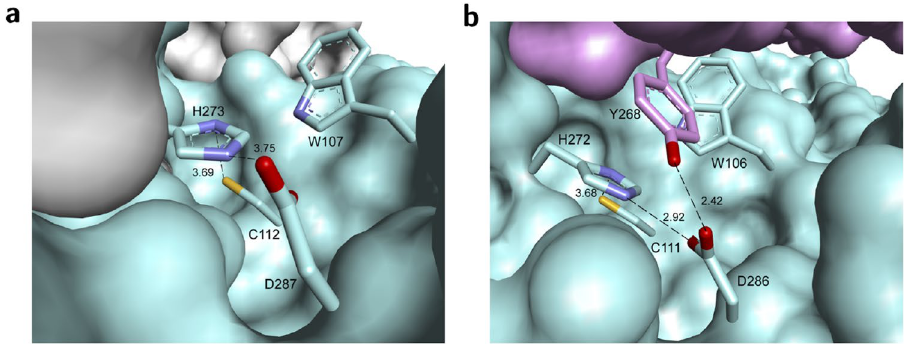
Figure 1. The active site of PL pro s contains a classic catalytic triad, composed of Cys–His–Asp, where Cys acts as nucleophile. ( a ) Unliganded catalytic center of the active site of PL pro SARS (PDB: 2FE8 10 ). ( b ) Unliganded catalytic center of the active site of PL pro CoV2 (PDB: 6W9C 37